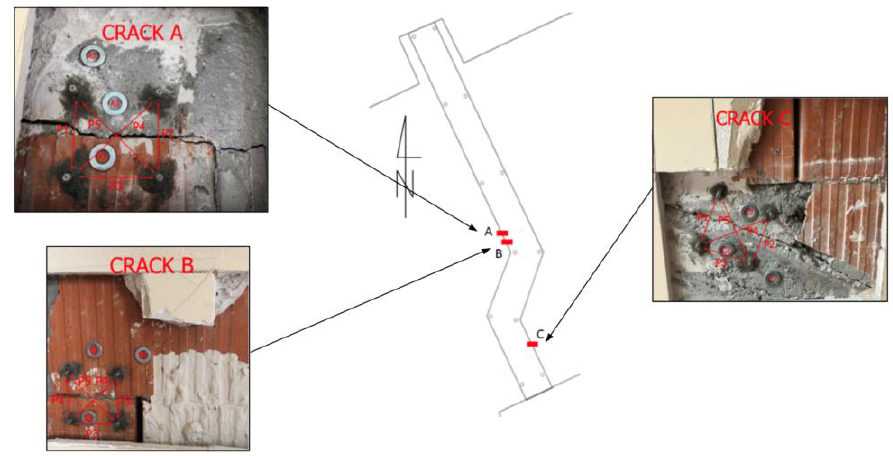
Figure 4. The scheme of the crackmeter location [own analysis].